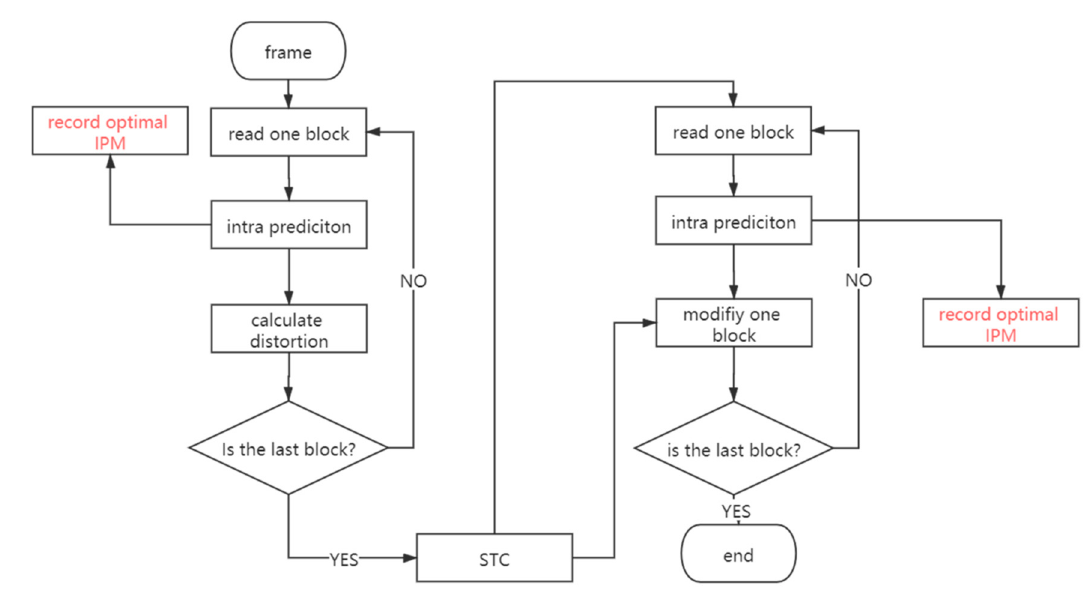
Figure 1. Experiment about the adaptive steganography embedding strategy. Table 1. Experimental results of the adaptive steganography embedding strategy. Video Sequence The Ratio of Optimal IPM